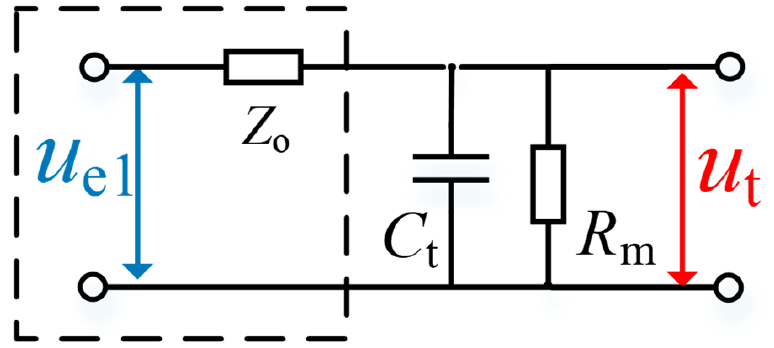
Figure 3. Thevenin equivalent circuit.